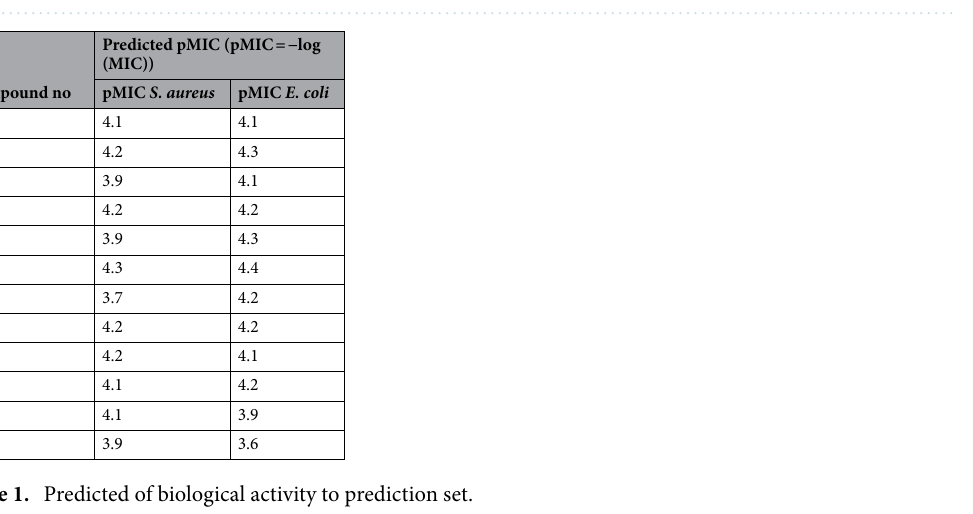
Figure 6. Molecular insight of SAR mechanism models demonstrate an average of actives analysis. ( A ) Active molecules generally have a positive field in red color area, and a negative field in the cyan color region, ( B ) active molecules commonly make hydrophobic interaction in the yellow color area, ( C ) average shape of active molecules. The A1–C1 belongs to the S. aureus and E. coli results placed in the A2–C2.